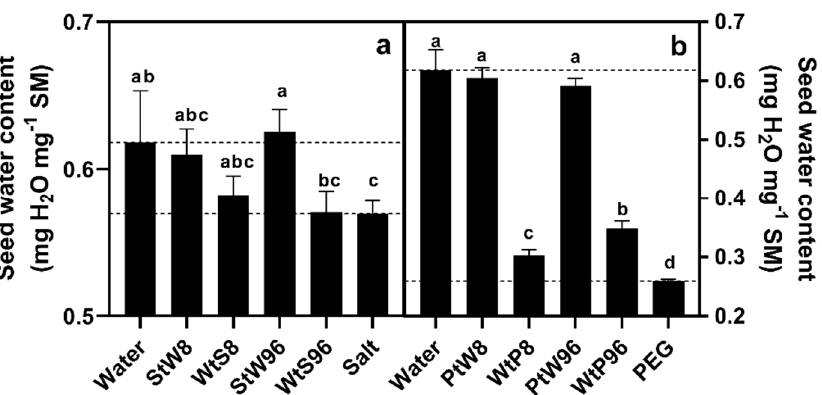
Figure 7. Seed water content after 314 h, for control seeds (Water, NaCl ( a ), PEG ( b )) and seed transferred from water to salt (WtS), salt to water (StW), water to PEG (WtP) or PEG to water (PtW) after 8 or 96 h.